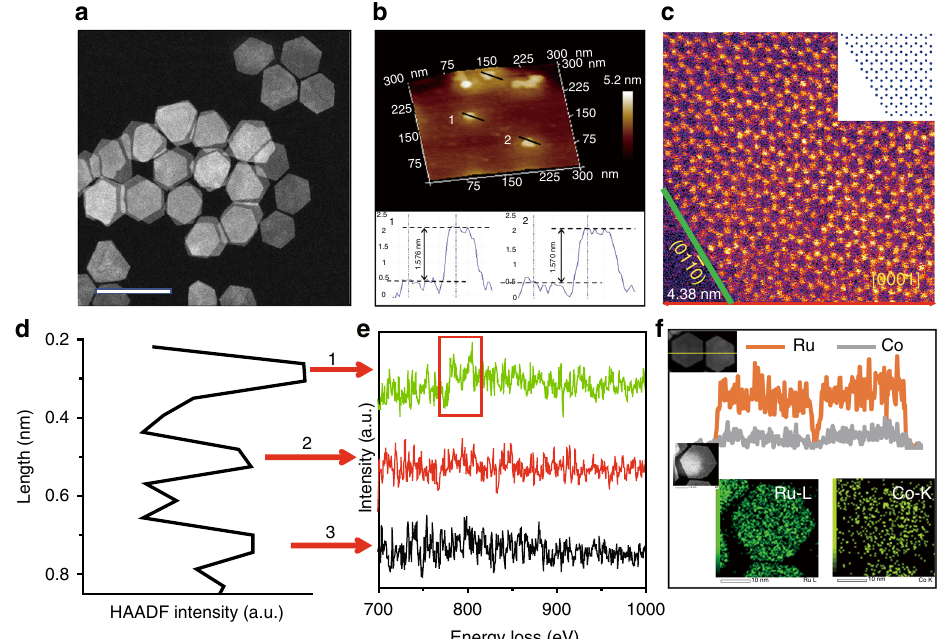
Fig. 1 Characterization of Co-substituted Ru NSs. Representative a STEM image. Scar bar: 50 nm. b AFM image. c Atomic resolution HAADF-STEM image of a single Co-substituted Ru nanosheet. False color was used to increase the contrast. Inset of c is the surface model of the nanosheet. d Line scanning pro fi le and e background subtracted EELS spectrum of the Co-substituted Ru NSs acquired from d . The red rectangle represents Co L 2, 3 -edge signal. f EDX line scanning pro fi le and EDX mapping of a single Co-substituted Ru